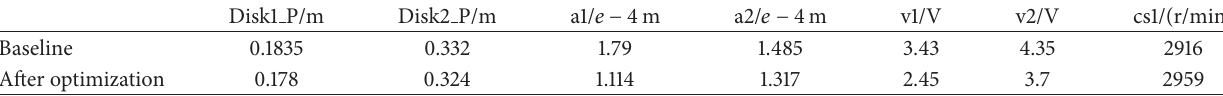
Table 2: Experimental optimization result of Disk1 P and Disk2